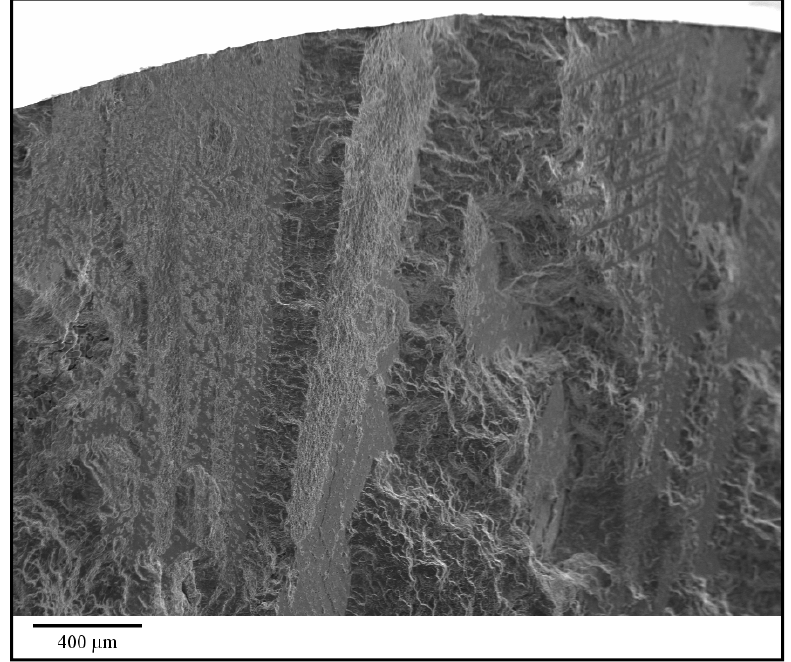
Figure 11. Slip plane area that occurs in both positions.